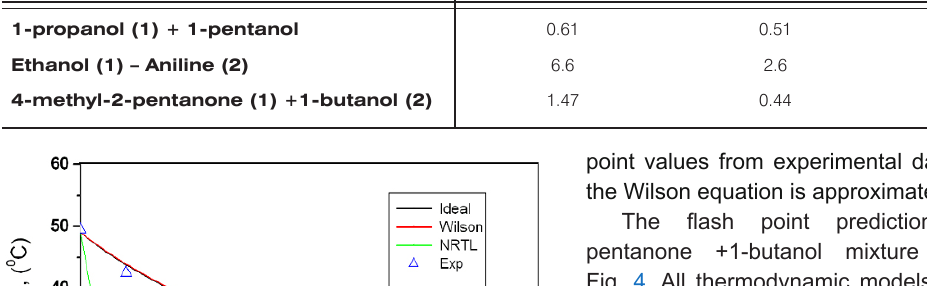
Fig. 4 . All thermodynamic models agree in their flash point predictions. The ideal solution model predicts higher but acceptable flash point values. Table 6 includes average absolute deviation (A.A.D.)